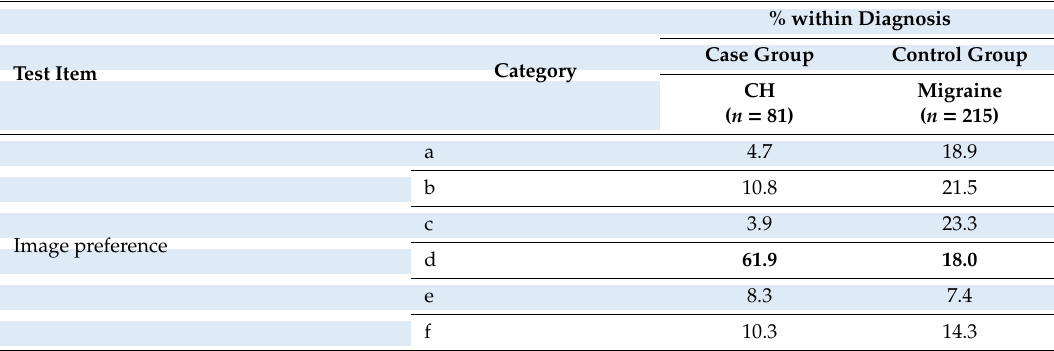
Table 3. Frequency distribution of the test scores classified by